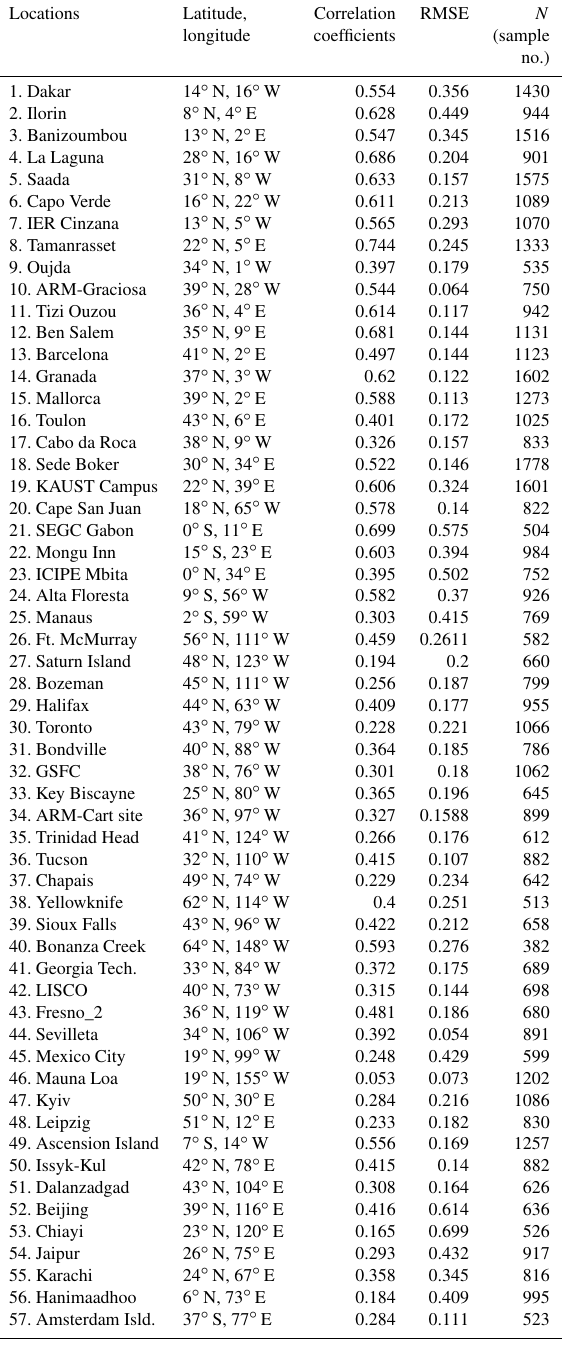
Table 2. Locations of AERONET stations, correlations, RMSE and number of paired observations with NGACv2.